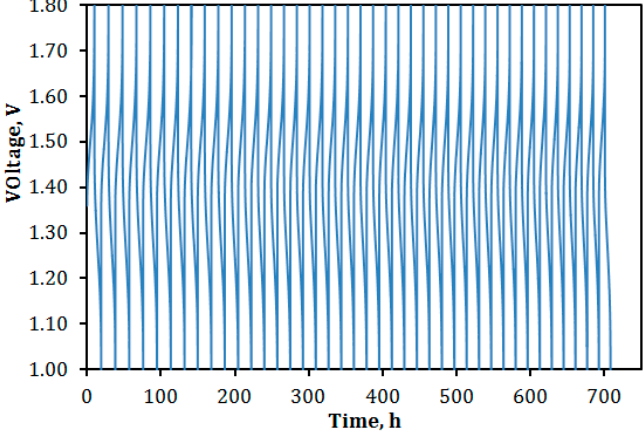
Figure 13. Cyclic charge-discharge curves of VPG-VRFB over a period of 30 days. Figure 12. Performance of the VPG-VRFB and Nafion-VRFB in charge-discharge operations: ( a ) charging and discharging curves at a current density of 30 mA/cm 2 , ( b ) coulombic efficiency (CE) as a function of current density, ( c ) voltage efficiency (VE) as a function of current density, and ( d ) energy efficiency (EE) as a function of current density.